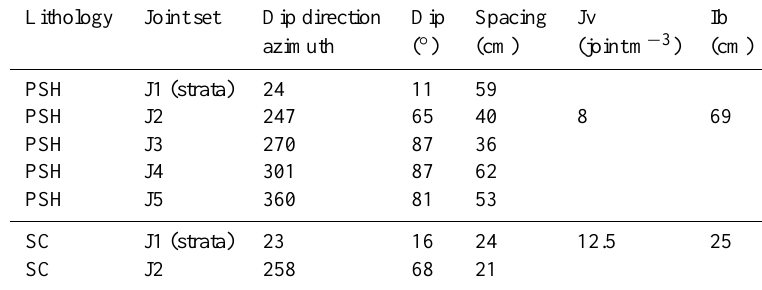
Table 1. Joint parameters from the field-based geomechanical surveys.